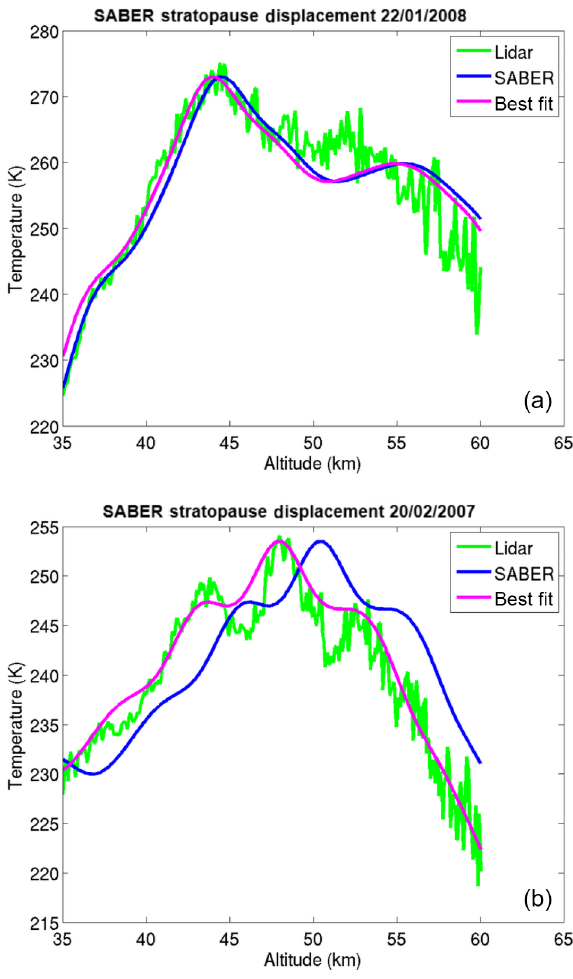
Figure 7. Panel (a) shows a case in which the lidar and SABER were well aligned in altitude. Panel (b) shows a case in which a ver- tical displacement of the SABER profile ameliorated the agreement with the lidar measurement.